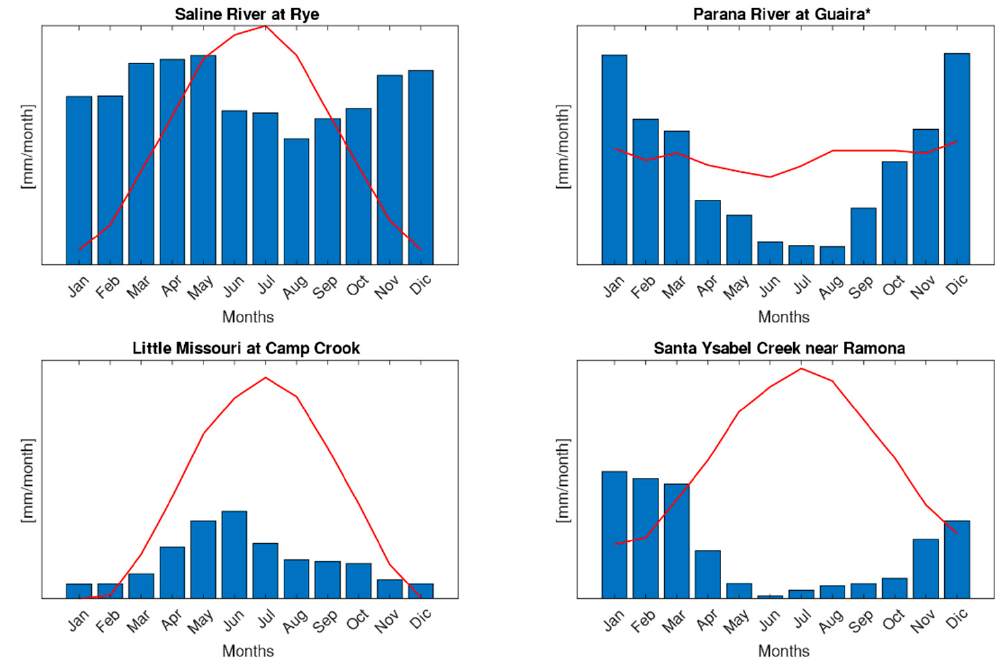
Figure 9. Seasonal patterns of monthly rainfall and potential evapotranspiration in the four considered case study basins. The red line represents the mean monthly potential evapotranspiration, whereas the blue bar represents the mean monthly precipitations from MOPEX database [35]. For the case study with an asterisk: the precipitation and potential evapotranspiration datasets respectively come from CRU TS version 4.00 [42], the CGIAR-CSI Global Aridity Index (Global-Aridity), and the Global Potential Evapo-Transpiration (Global-PET) Climate Database [43,44].